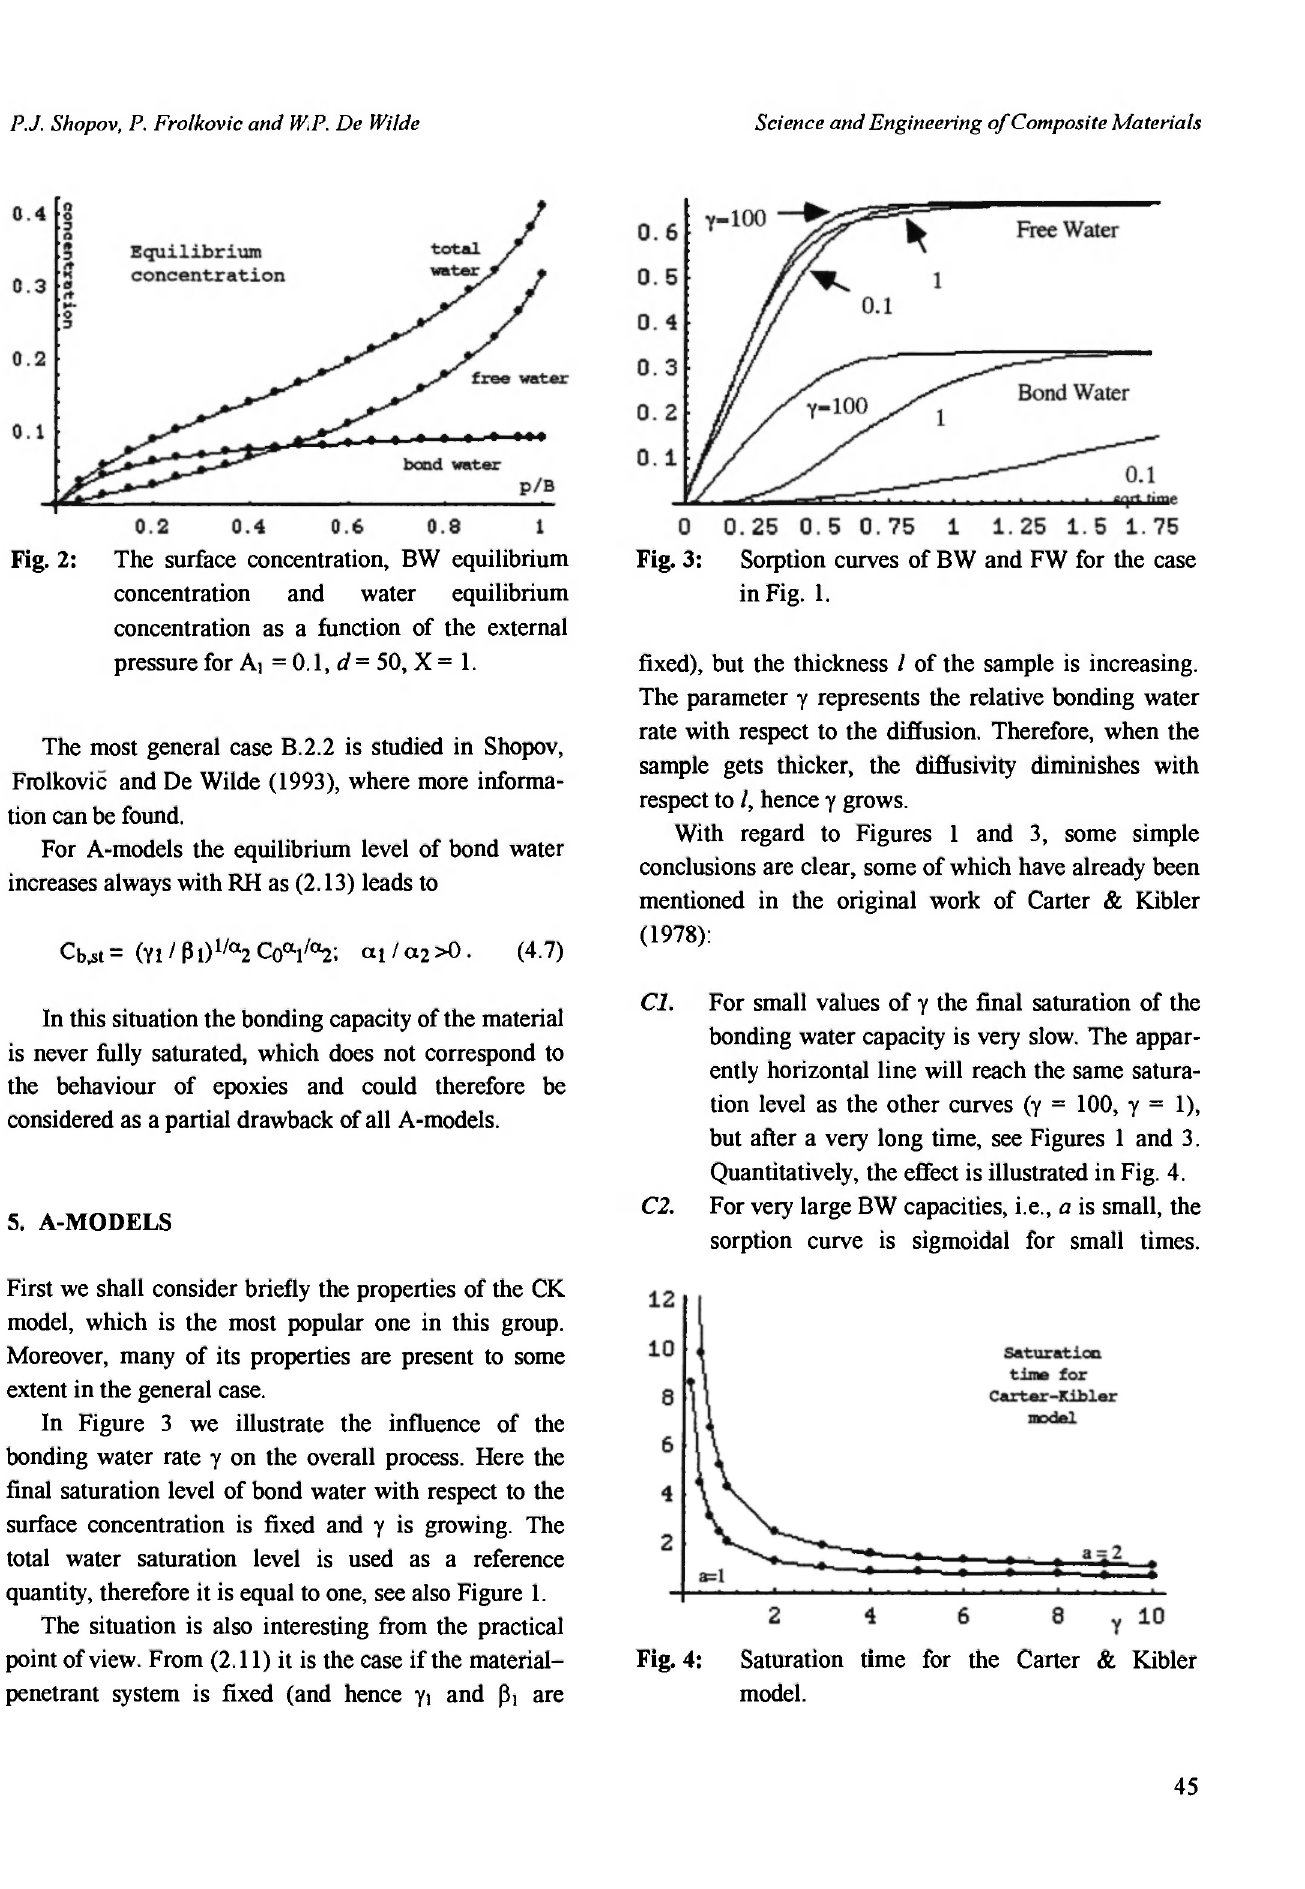
Fig. 4: Saturation time for the Carter & Kibler